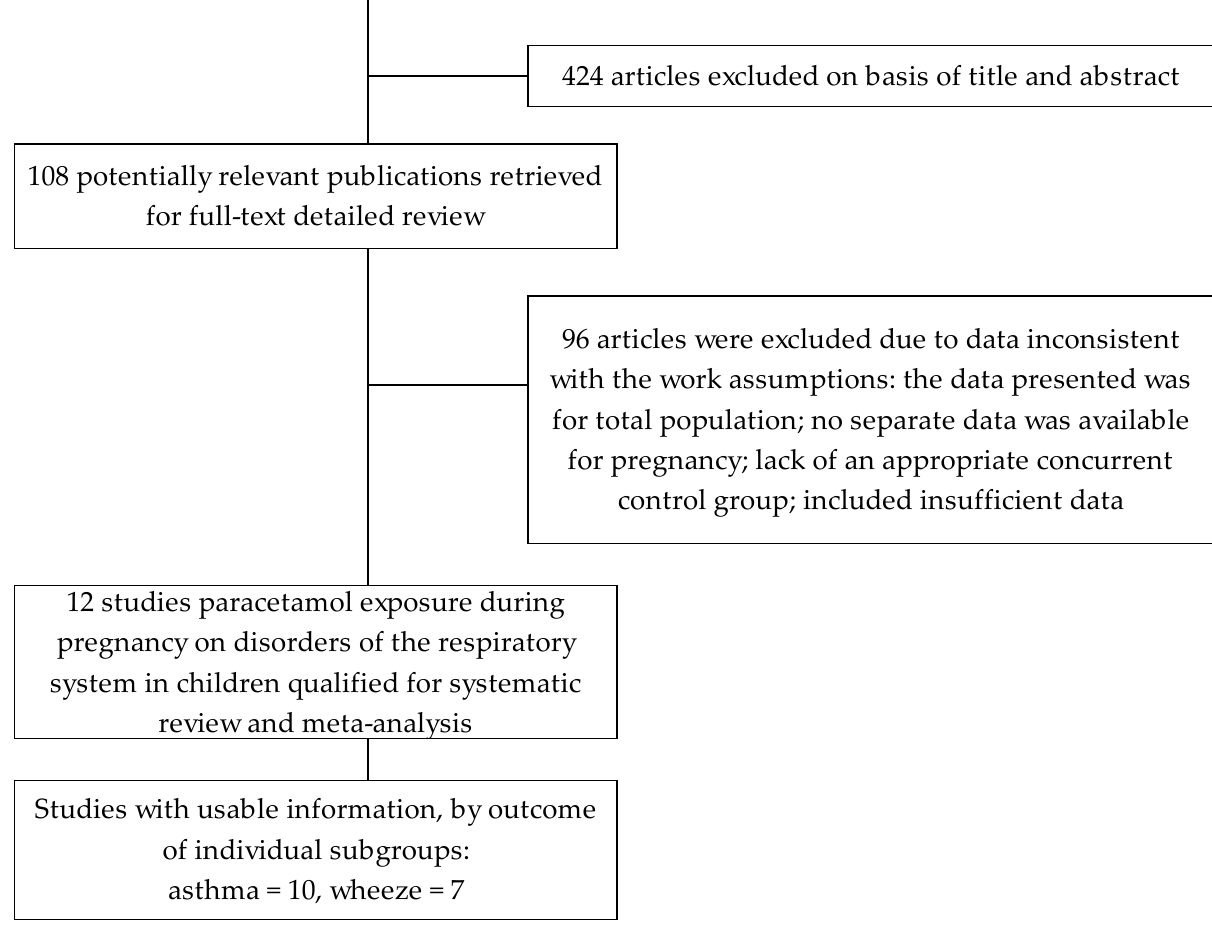
Figure 1. Flow diagram of literature search and research selection procedure.